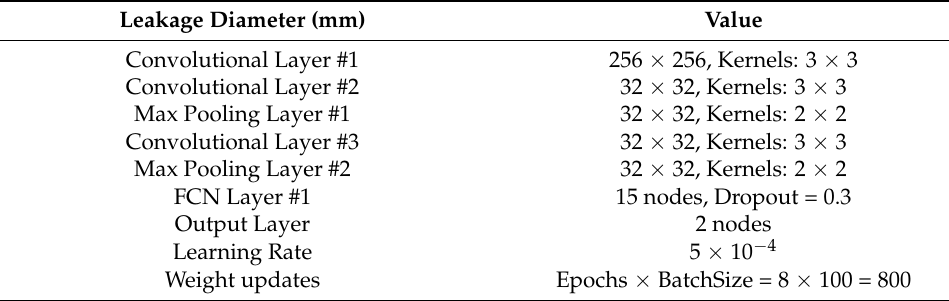
Table 4. Hyperparameter selection—Convolutional Neural Network.